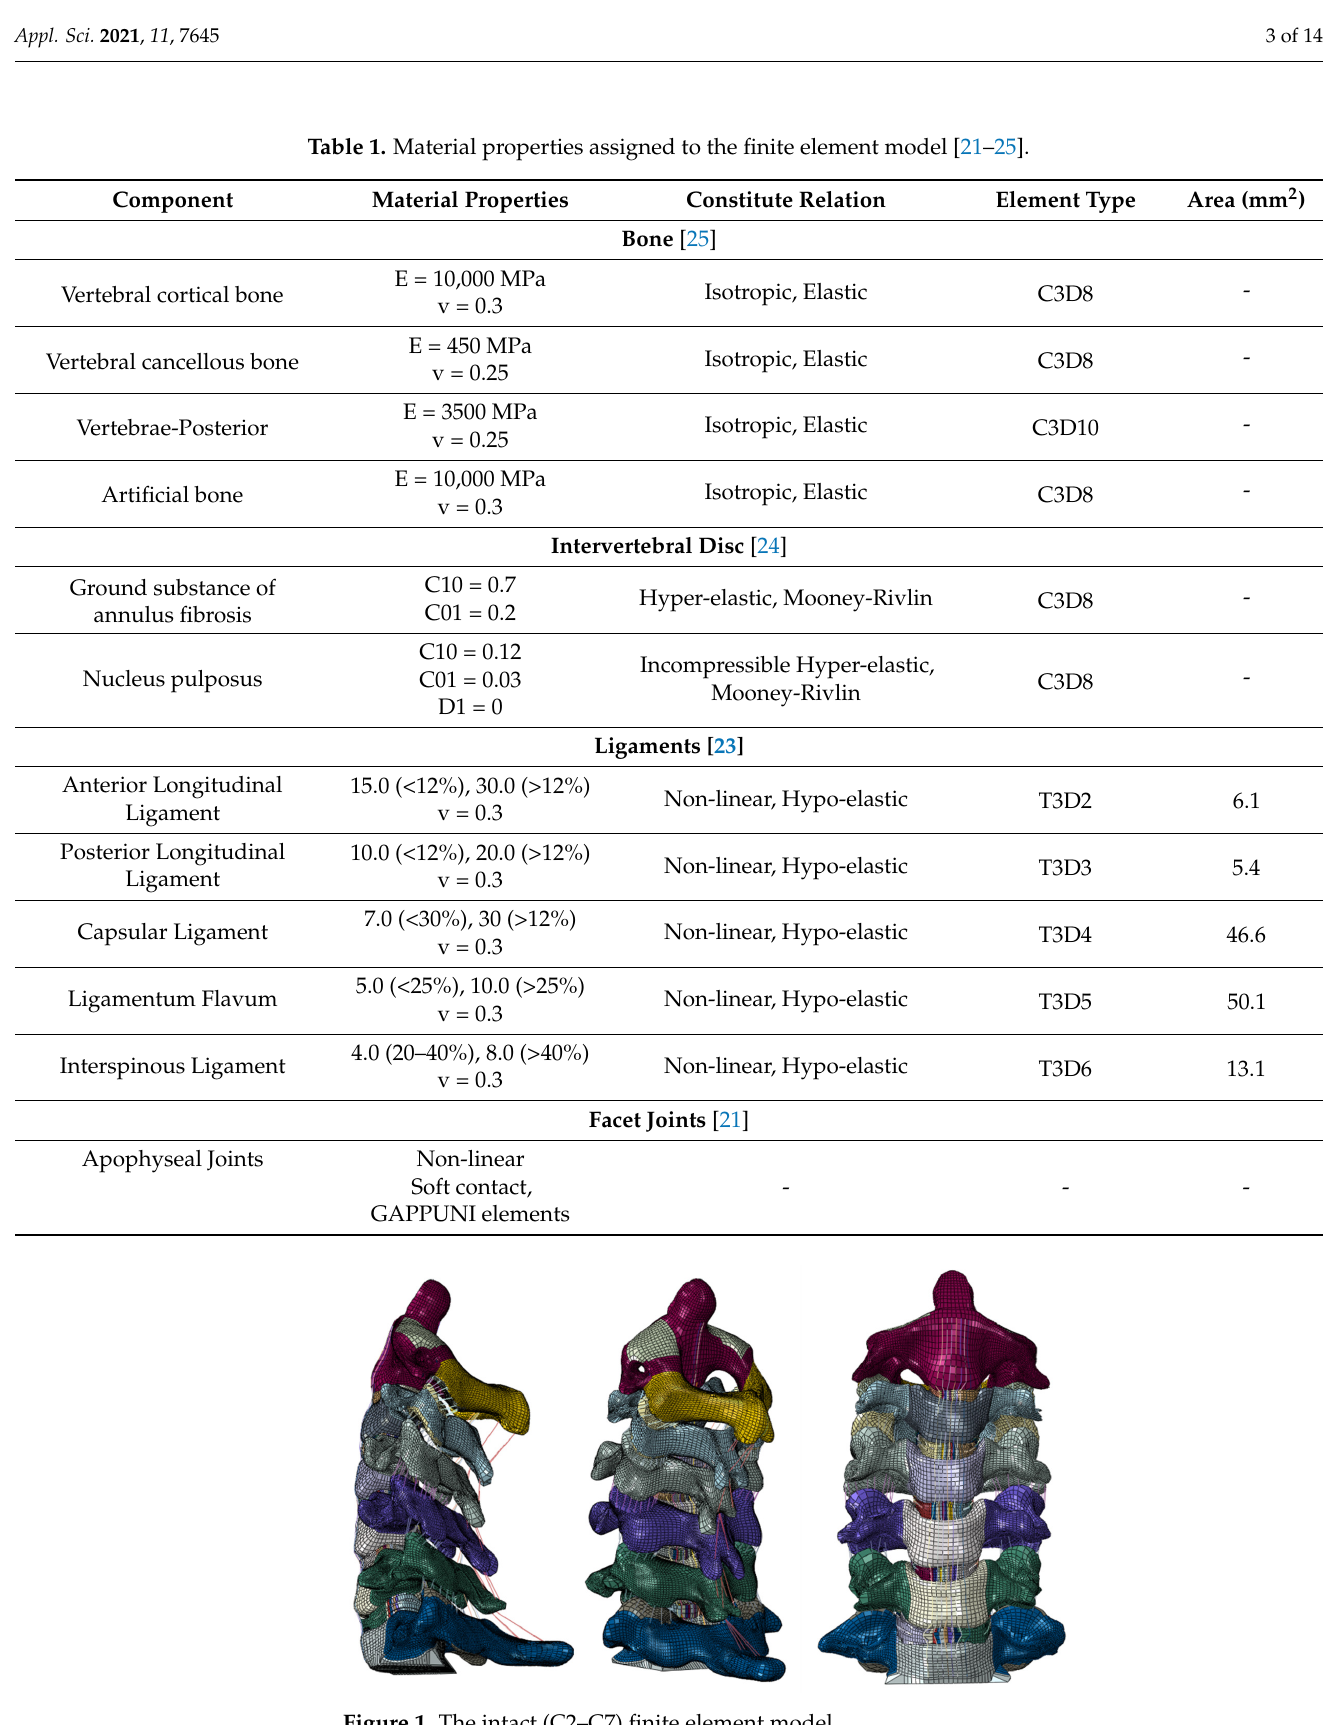
Table 1. Material properties assigned to the finite element model [21–25].